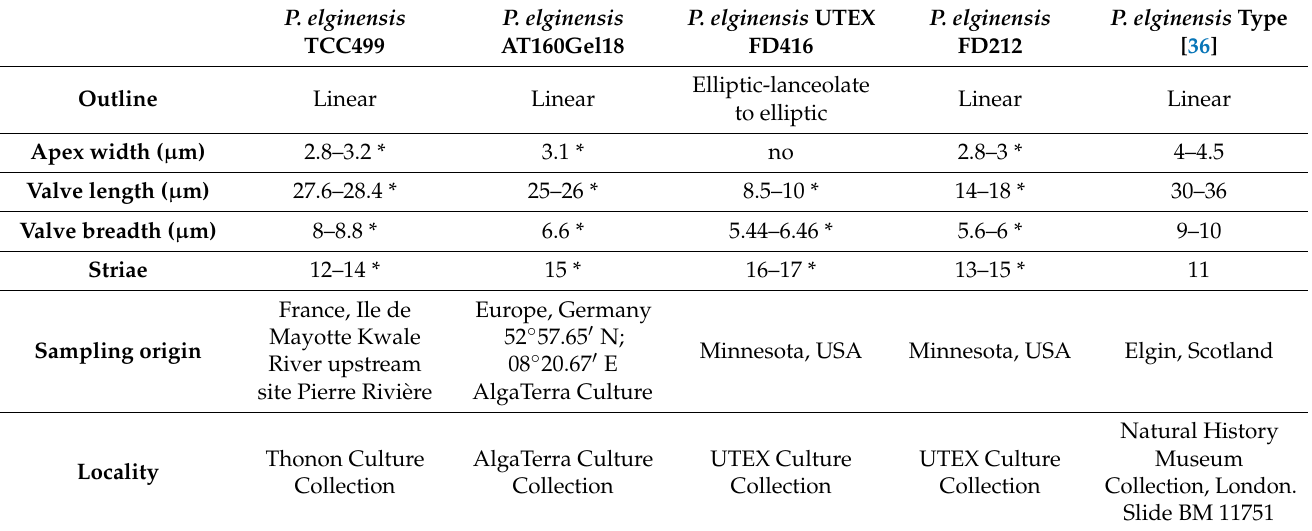
Table 1. Comparison of morphological features of vouchers of Placoneis elginensis